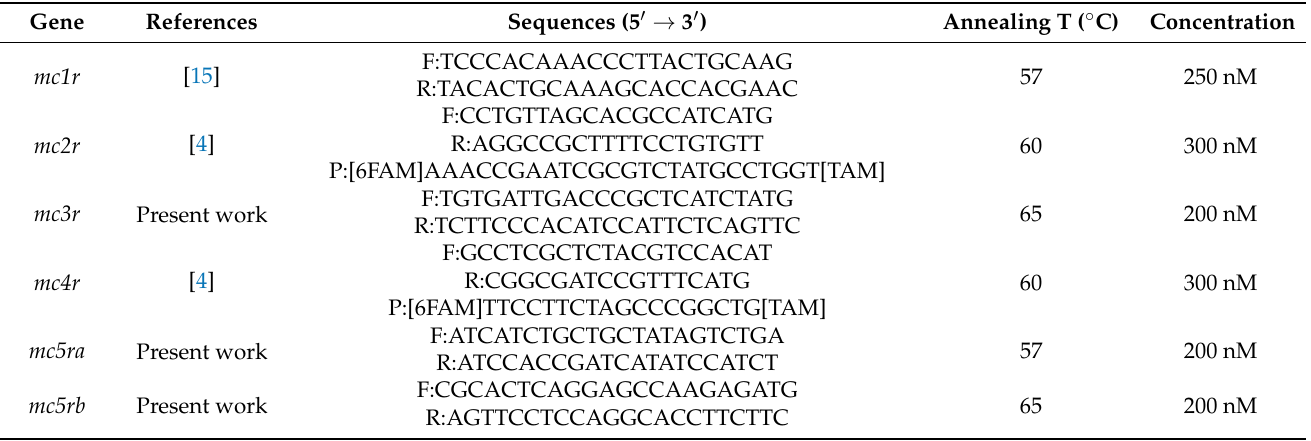
Table 1. Primers and probes used for gene expression studies by quantitative